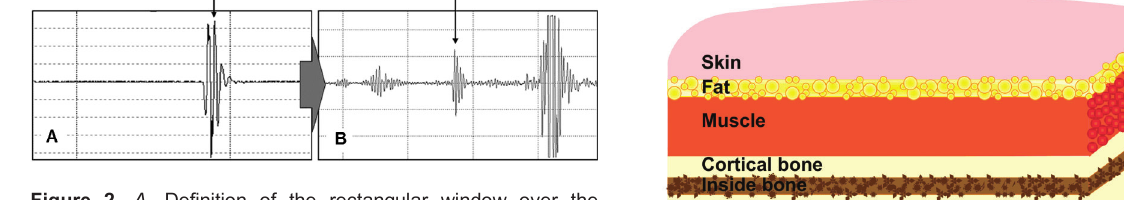
Figure 2. A , Definition of the rectangular window over the reflected echo from the reference steel plate (extreme limits on 10% of peak amplitude). B , Reference rectangular window placed over the echo from interface muscle/bone. The remaining echoes on the right with a 4- m s duration are from backscattering inside the bone.